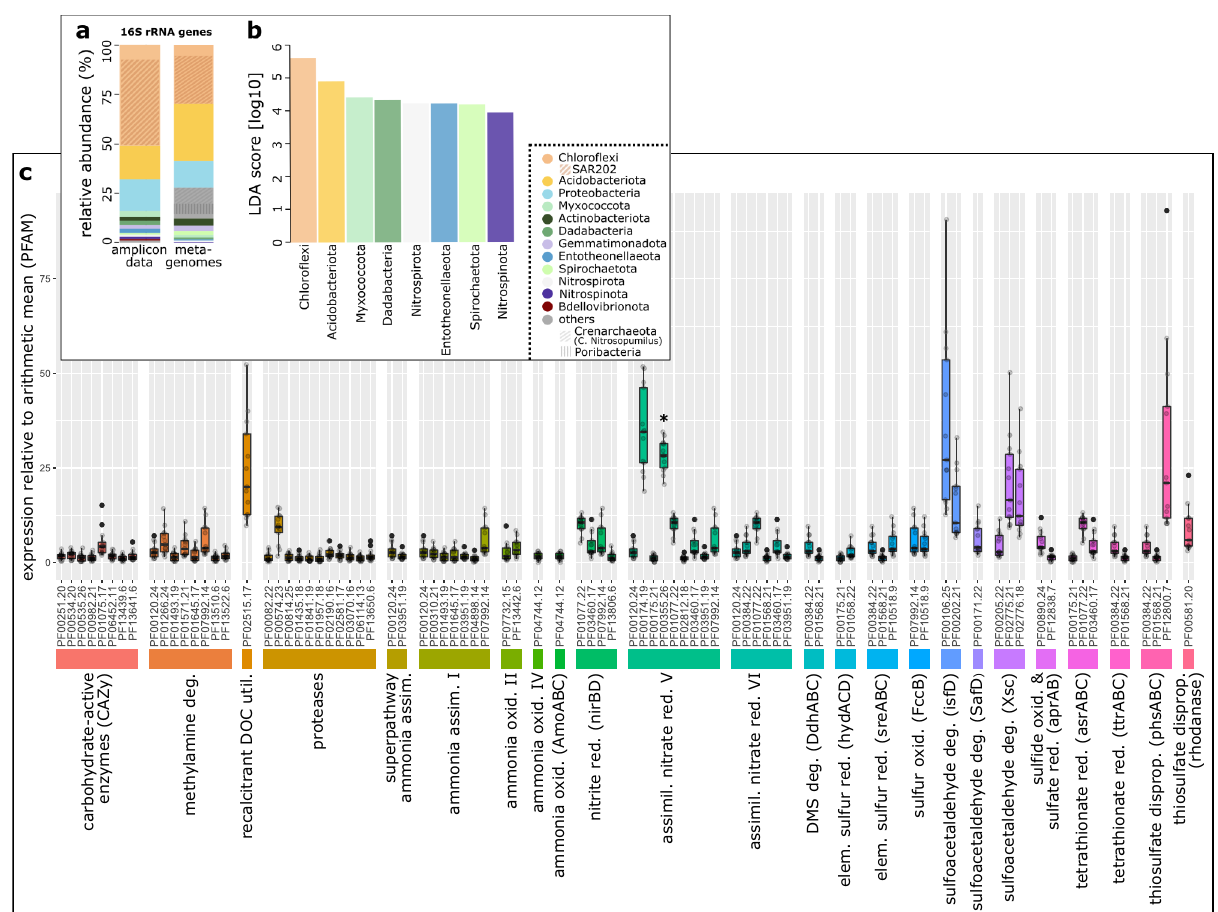
Fig. 6 Microbial diversity and expression pro fi les. a Average microbial community composition of G. parva ( n = 11 biological replicates) based on microbial phylum level. Taxa in the legend are sorted in descending order of mean relative abundance in the amplicon data. The term “ other ” refers to microbial phyla with an average abundance below 1% in the amplicon dataset. In particular these are: Bacteroidota, Deinococcota, Patescibacteria, Schekmanbacteria, Poribacteria, Verruocmicrobiota, PAUC34f, NB1-j, Calditrichota, Desulfobacterota, Margulisbacteria , the SAR324 clade , Firmicutes, Anck6 , and MBNT15. Crenarchaeota and Poribacteria are underrepresented in the amplicon data due to the ampli fi cation primers, but the high relative abundance of these phyla is shown in the metagenomic data. b Linear discriminant analysis (LDA) effect size plot based on amplicon data showing microbial phyla which are signi fi cantly enriched in G. parva in comparison to the ambient seawater. c Expression levels in the microbiomes of G. parva ( n = 13 biological replicates). Shown are PFAMs with a mean expression above average and being either a marker gene in the MEBS analysis or representing a protease, chitinase, CAZy enzyme, or involved in refractory DOM utilization. Values for PF00355.26 (marked with an asterisk) were divided by 10 to fi t a y-axis with higher resolution. The lower and upper hinges of the boxes correspond to the 25th and 75th percentiles and the whiskers represent the 1.5x inter-quartile range (IQR) extending from the hinges. The median is indicated in the box plot as solid line. assim. assimilation, assimil. assimilatory, deg. degradation, disprop. disproportionation, oxid. oxidation, red. reduction, util.